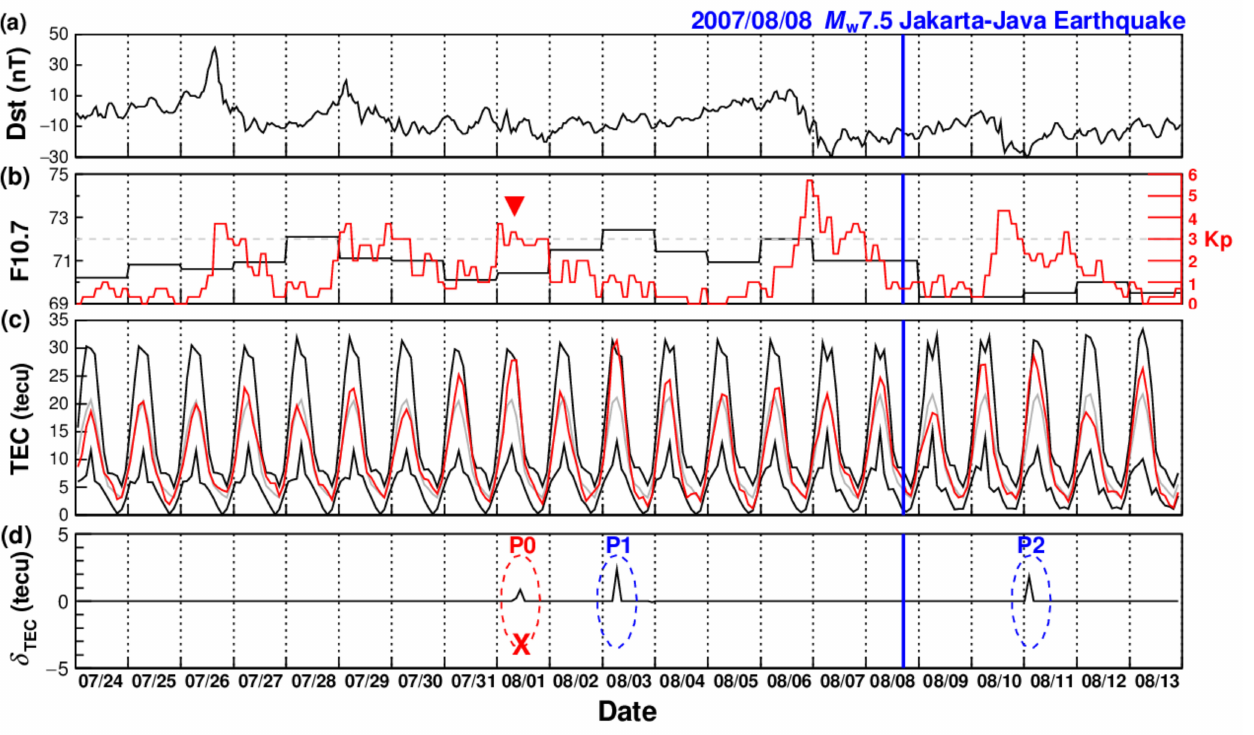
Figure 2. The ionospheric TEC temporal (from 24 July to 13 August 2007) analysis for the M w 7.5 Jakarta–Java earthquake. Subpanel ( a , b ) represent the Dst, Kp and F10.7 indices, respectively. The gray dash line in ( b ) indicates the Kp index equals to 3.0. Subpanel ( c ) shows the observed TEC value (red), 30-day running median value (gray) and the upper-lower bound (black), respectively. Three periods of TEC temporal anomalies (P0–P2 illustrating with elliptic curves) were filtered out and shown in Subpanel ( d ). The blue vertical lines point to the moment that the main shock